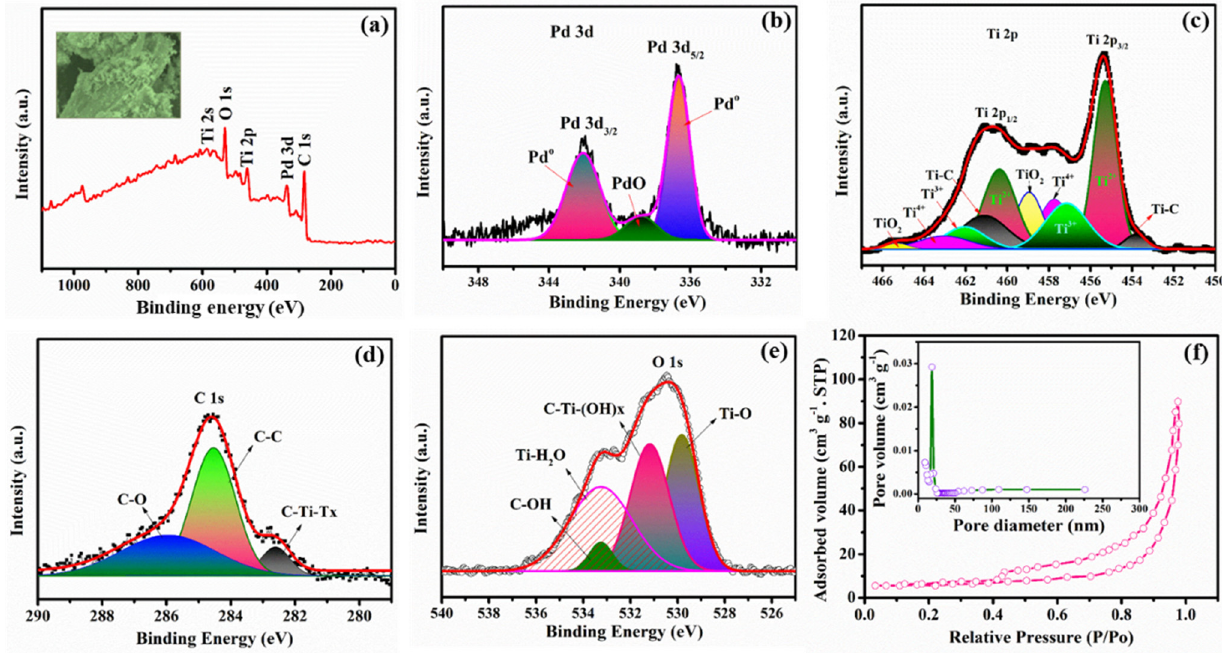
Figure 3. ( a ) The XPS survey spectra of Pd-MXene nanocomposite, ( b – e ) high resolution deconvo- luted spectrums of Pd 3d, Ti 2p, C1s, and O1s, and, ( f ) Nitrogen adsorption and desorption isotherms with BJH pore size distribution of Pd-MXene nanocomposites.